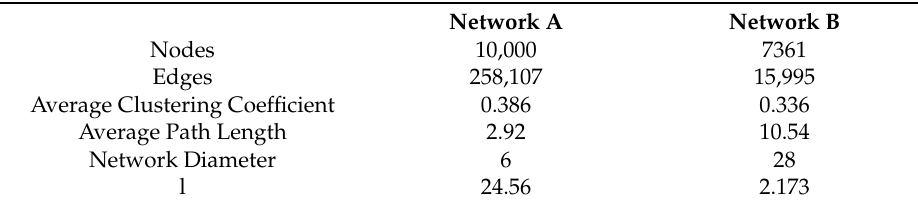
Table 1. The comparisons of Network A and Network B.